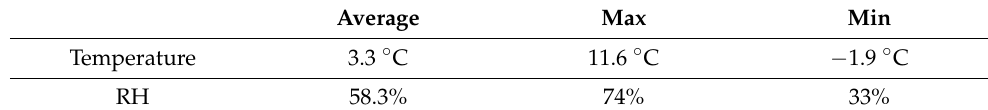
Table 8. Statistics of indoor environmental parameters for W1.